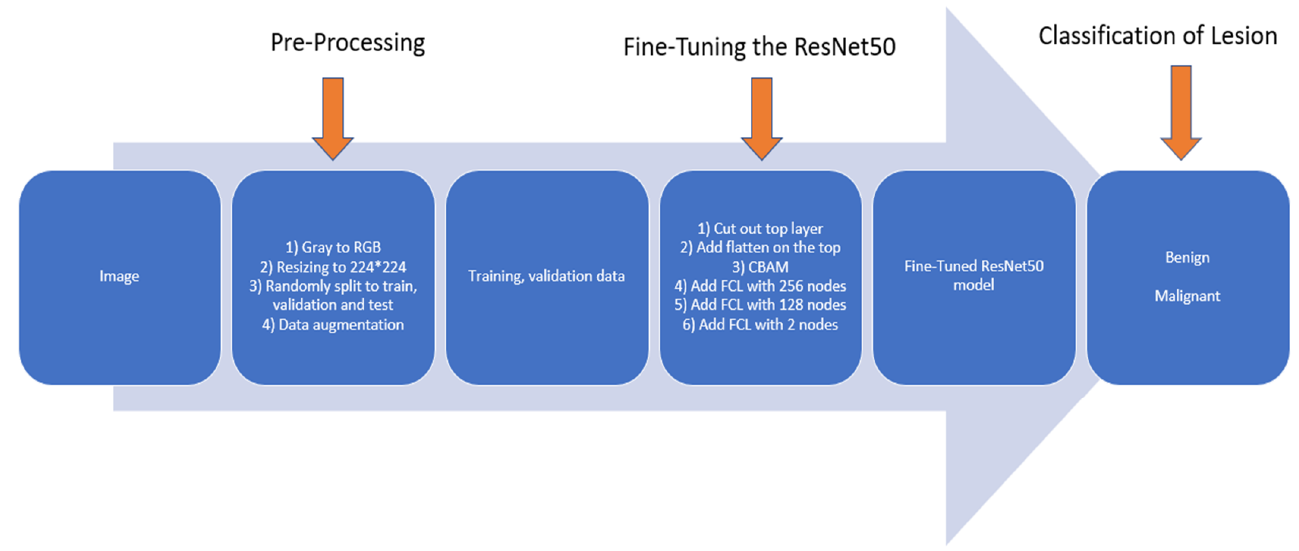
Figure 6. Schematic of our proposed CBAM-based ResNet50-model-based transfer learning